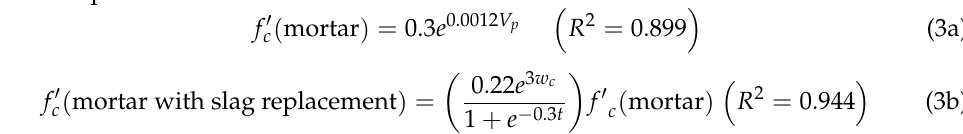
Figure 8. Calculated compressive strength values-to-measured compressive strength values ratio using the proposed multivariable strength prediction model—Equation (3b) [38–41].